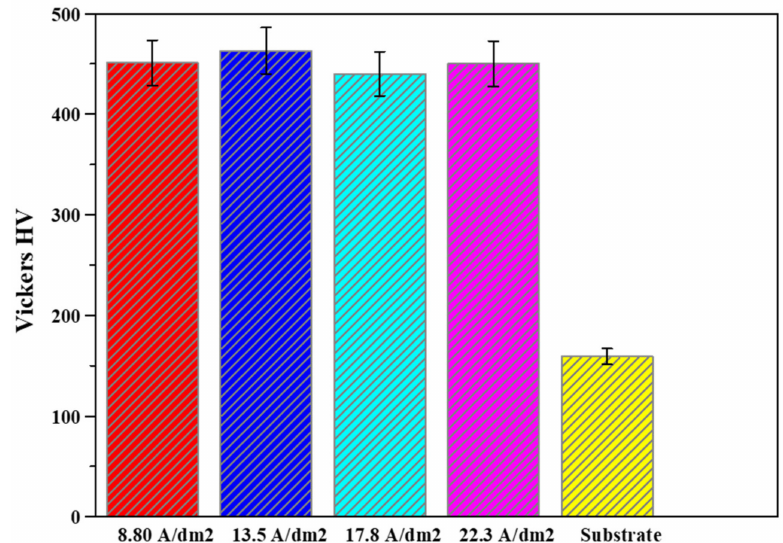
Figure 6. Vickers hardness of the substrate and Al 7075 samples PEO-coated under different current